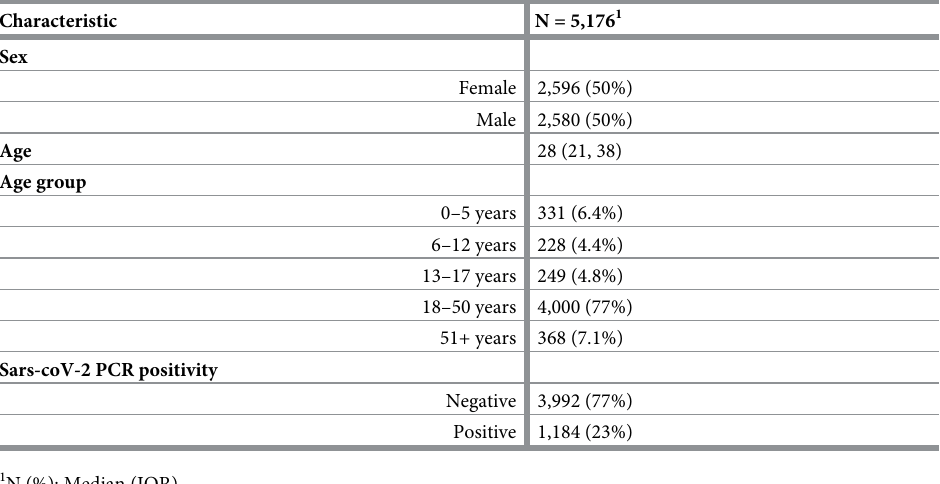
Table 1. Participant characteristics for main